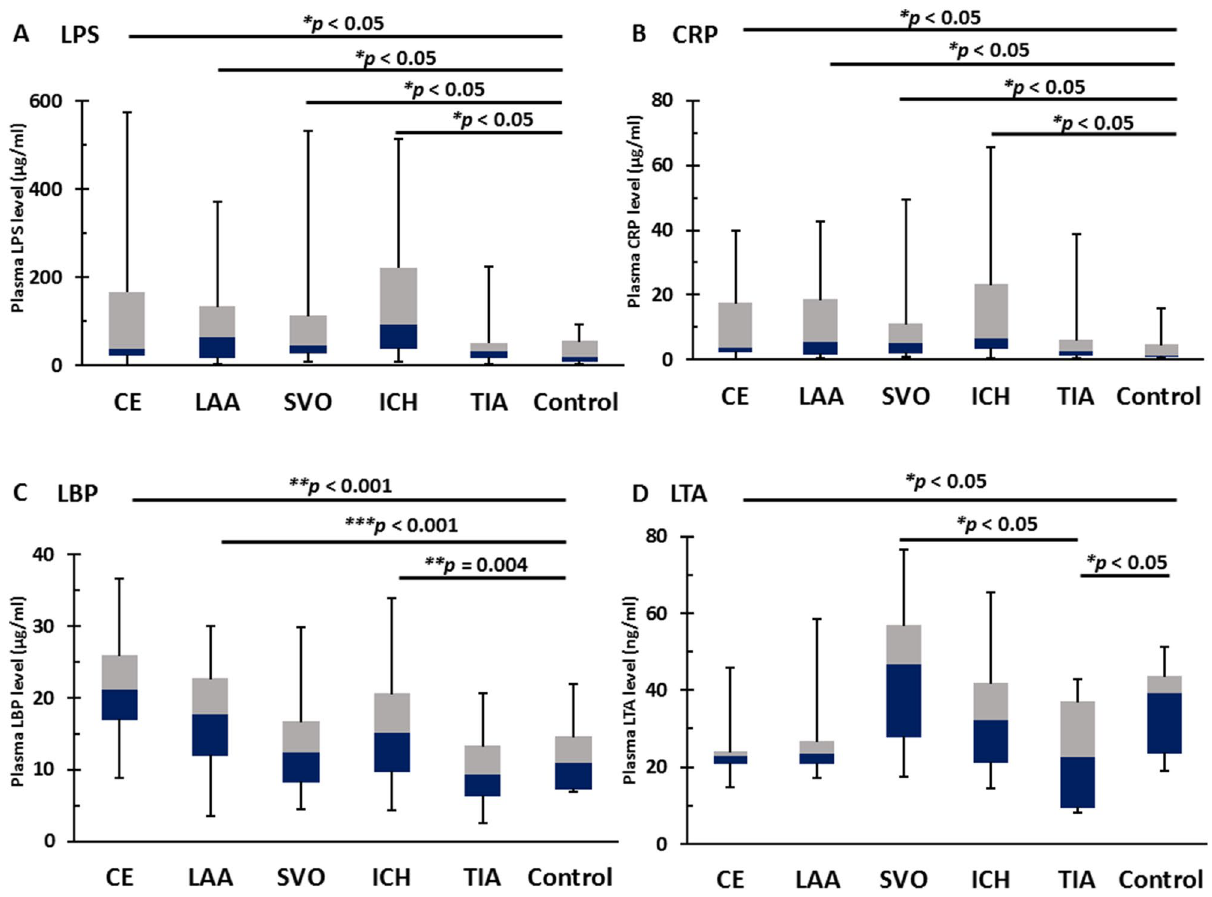
Figure 1. ELISA for LPS, LBP, CRP, and LTA for different causes of stroke and TIA vs controls. ( A ) The plasma levels of LPS, a component of the cell wall of all Gram-negative bacteria, were significantly higher in patients with intracerebral hemorrhage (ICH), CE stroke, LAA stroke, and SVO stroke compared to age-, sex- and vascular risk factor-matched healthy controls. The difference between LPS levels in TIA and healthy control was not significant. ( B ) The plasma levels of CRP, the classical acute-phase protein, were significantly higher in ICH, CE stroke, LAA stroke, and SVO stroke than healthy controls. The difference of CRP levels between TIA and healthy controls was not significantly different. ( C ) The plasma levels of LBP, an acute-phase protein that binds to LPS, were significantly higher in patients with CE stroke, LAA stroke, and ICH compared to healthy controls. The difference between LBP levels in SVO stroke and TIA were not significantly different from controls. ( D ) The plasma levels of LTA, a Gram-positive bacterial component, were significantly higher in SVO stroke compared to TIA. LTA levels were lower in CE stroke and TIA compared to controls. The difference of LTA levels between LAA stroke and ICH and healthy controls was not significant. LPS lipopolysaccharide, LBP lipopolysaccharide binding protein, CRP C-reactive protein, LTA lipoteichoic acid, CE cardioembolic, LAA large artery atherosclerosis, SVO small-vessel occlusion, ICH intracerebral hemorrhagic, TIA transient ischemic attack, VRFs vascular risk